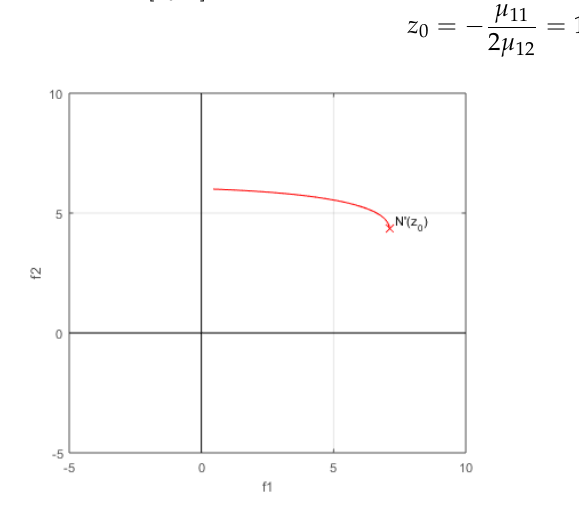
Figure 6. Pareto boundary of the Nash payoff